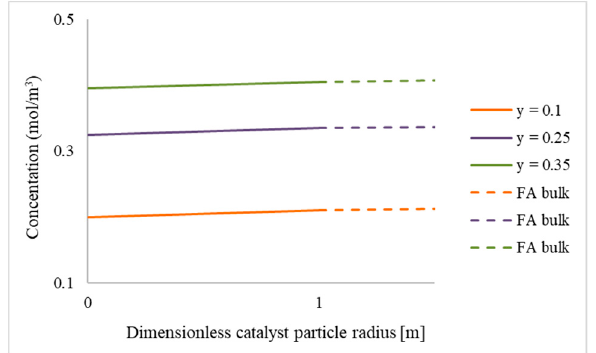
Figure 9. Concentration of formic acid within the catalyst particles and in the bulk fluid at x = 1.25 cm, generated from modelling. Reaction conditions: temperature = 30 °C; pressure = 1 bar; inlet flow = 0.05 mL/min; 0.1 g catalyst of 5 wt.% Pd on carbon.